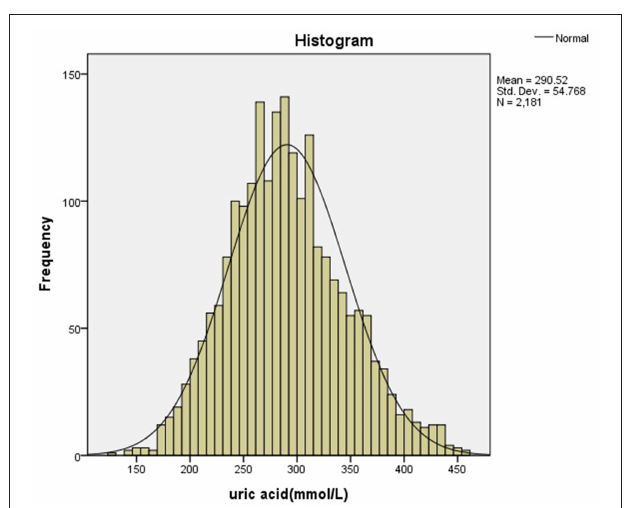
FIGURE 1 | The selection of participants.